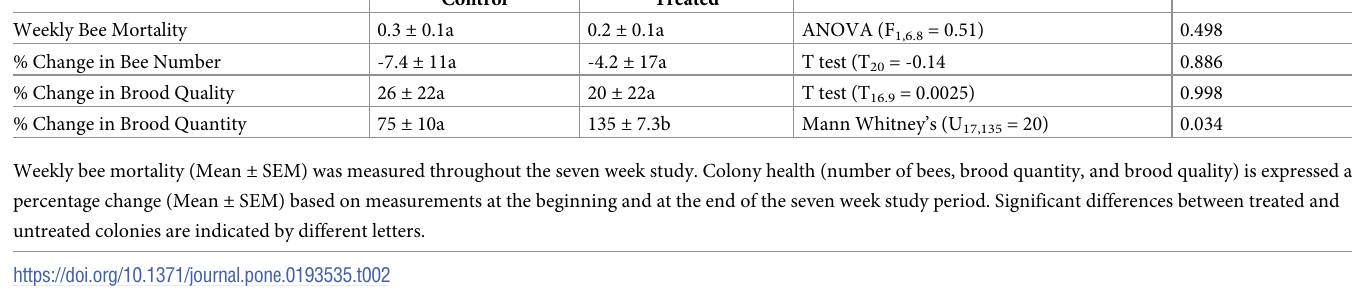
Table 2. Comparison of weekly bee mortality and colony health among insecticide-treated and–untreated sites. Parameters Mean ± SEM Statistical Test P value Control Treated Weekly Bee Mortality 0.3 ± 0.1a